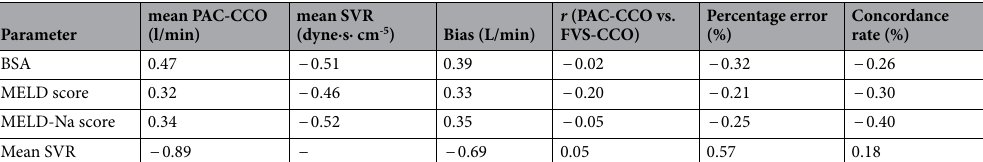
Table 4. Pearson correlation coefficients and patient profile data. Data in this table were calculated based on the individual patient data in Supplemental Tables 1 and 2.